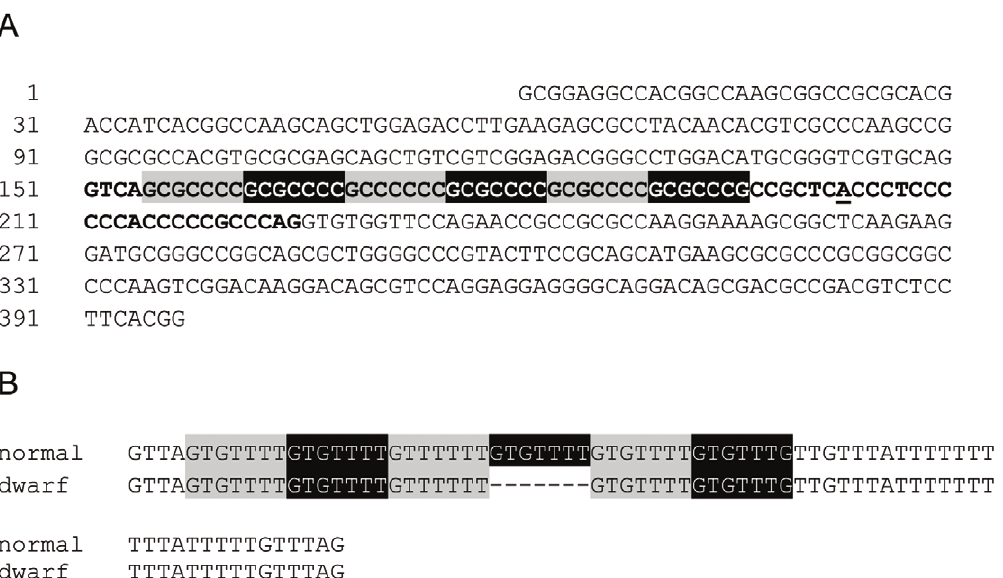
Figure 2. Structure of exon 5, intron 5, and exon 6 of canine LHX3 . (A) The DNA sequence derived from BAC clone RP81-17A4 fills a gap in the reference genome sequence build 2.1. The intron is indicated by bold characters and the putative splice branch site is underlined. The intron contained 6 repeats of the 7 bp sequence GCGCCCC, indicated by alternating grey and black blocks. The G at position 3 of the third repeat was mutated to a C and the last repeat ends with a G-residue. The Genbank accession number of the DNA sequence is Q913875. (B) Comparison of the DNA sequence of intron 5 in the normal German shepherd dogs B4 and C8 and the dwarfs B3 and C6 after bisulfite treatment of genomic DNA. The treatment converts unmethylated cytosine residues to uracil residues, which act like thymine in the PCR. The intron in the normal dogs B4 and C8 (Fig. S2) consisted of 75 bp and contained 6 repeats of the 7 bp sequence which are converted to GTGTTTT, indicated by alternating grey and black blocks. Seven consecutive nucleotides in the region of repeats 4–6 are deleted from the intron of the dwarfs B3 and C6, indicated by dashes (NM_001197187, c.622-37-31del).